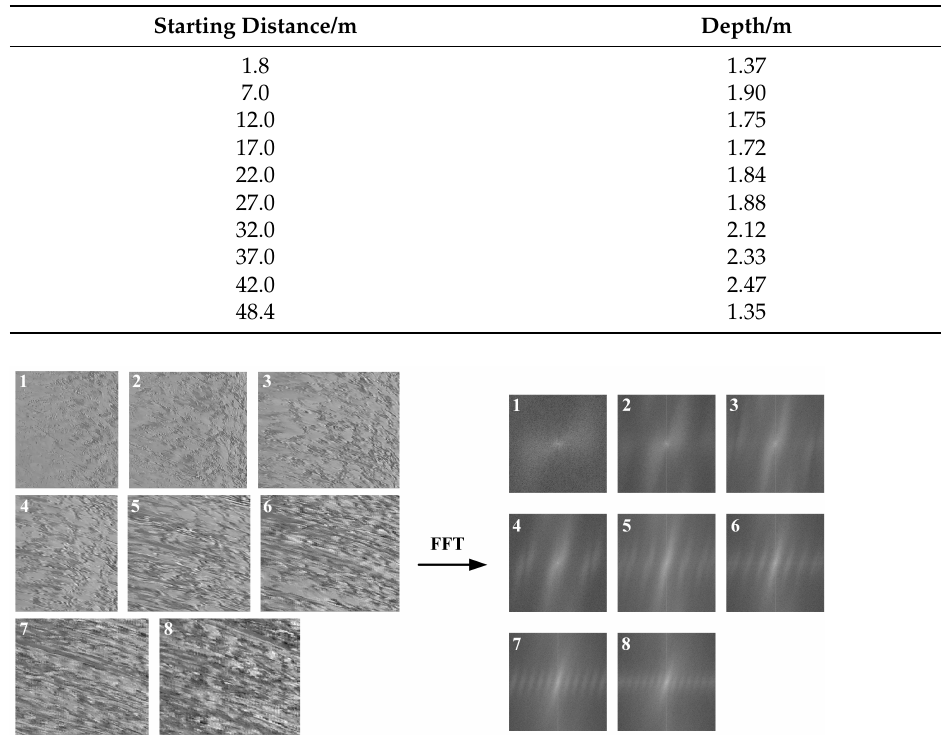
Figure 15. Layout diagram of the ground mark and search lines in a comparison test. Table 4. Sectional data of the comparison experiment.